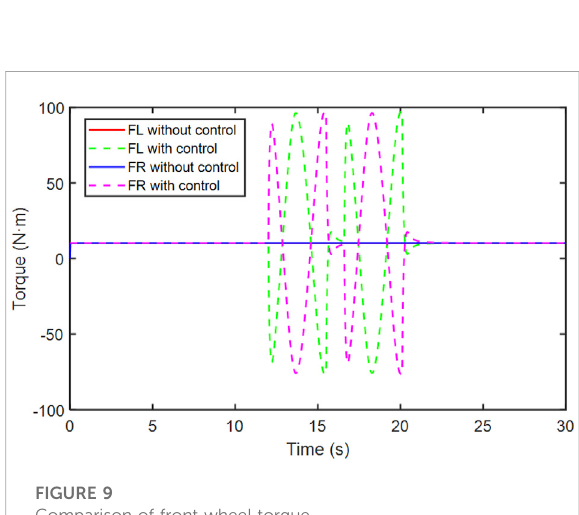
FIGURE 7 Stable region in the sideslip angle and angular velocity phase portrait.